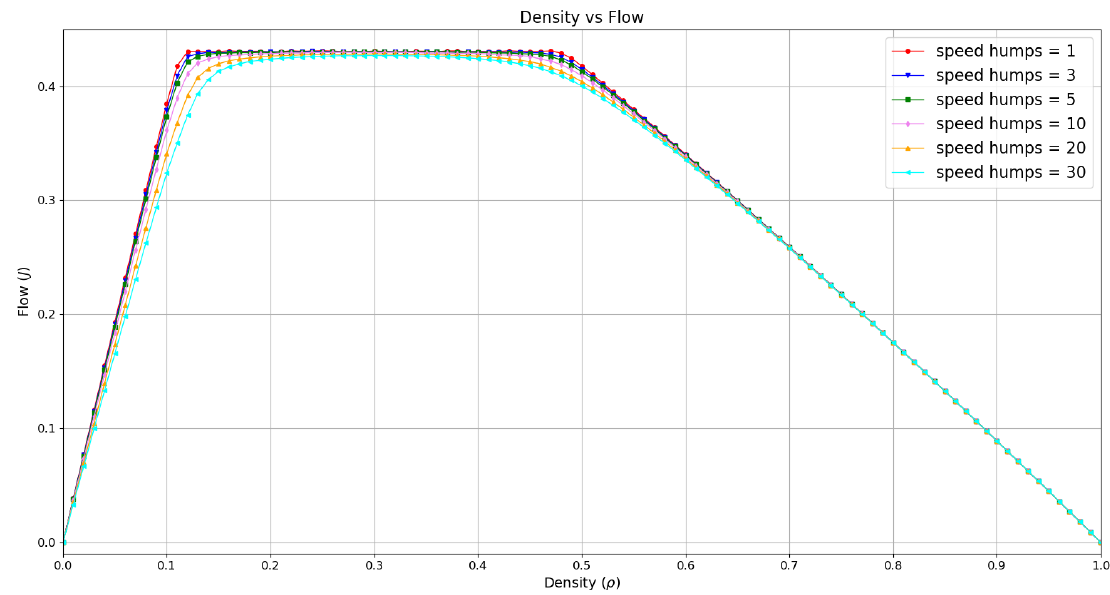
Figure 4. Flow J as a function of density. The flow is given as the average number of vehicles passing through a cell per simulation step, and the density ρ = N / L .